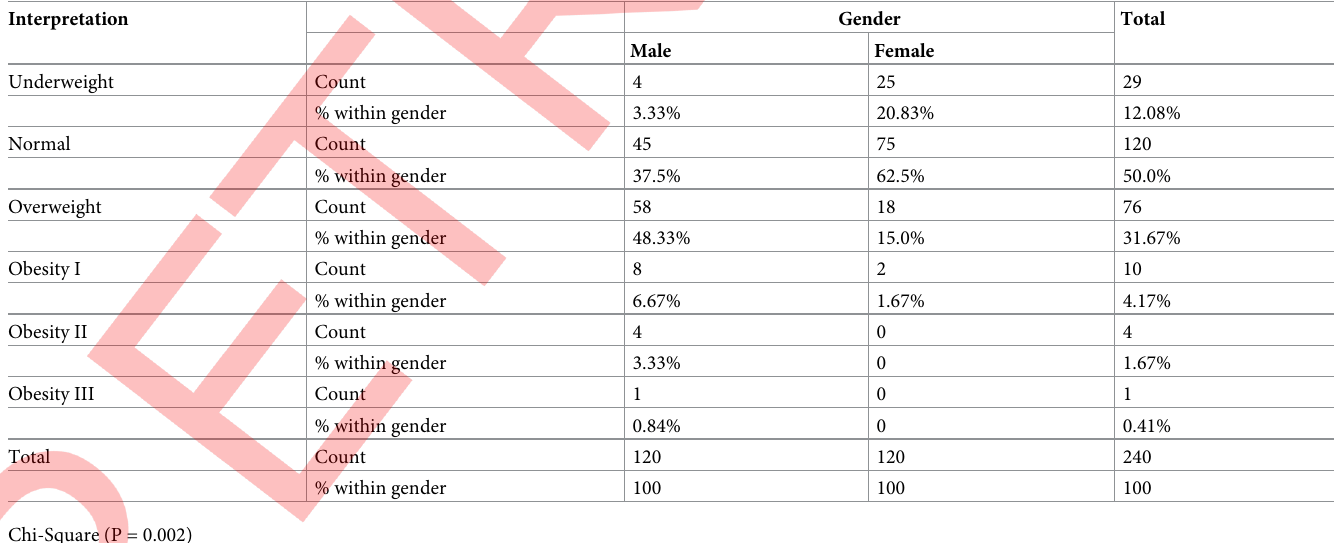
Table 4. Body mass index (BMI) of the students (n = 240) according to WHO (1998) classification.